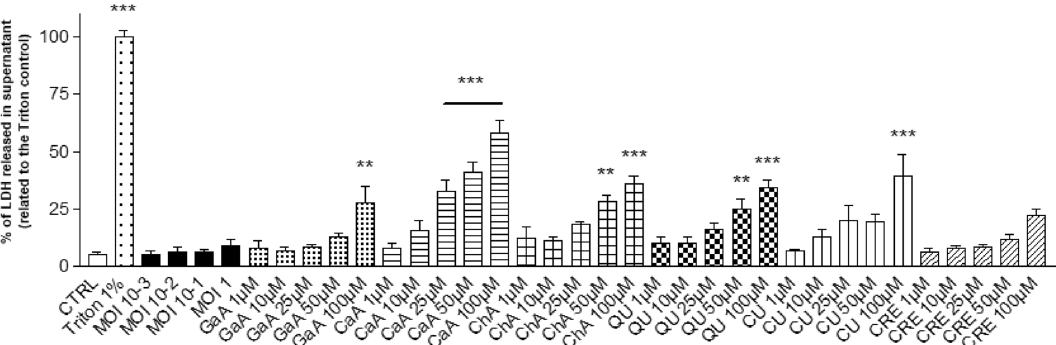
Figure 2. Concentration-dependent cytotoxic effects of phenolics or ONNV on cultured HSF cells. Cells were infected by ONNV (MOI 10 –3 to 1) or phenolics (1 to 100 µM) for 24 h. Released LDH in culture medium was measured using a colorimetric-based method (CytoTox 96 Non-Radioactive Cytotoxicity Assay) and expressed relative to the maximum release by application of a lysis buffer (Triton 1%). Reported values are means ± SEM of three independent experiments and p value was calculated using the Bonferroni multiple comparison test (** p < 0.01; *** p < 0.001) with untreated cells (CTRL).